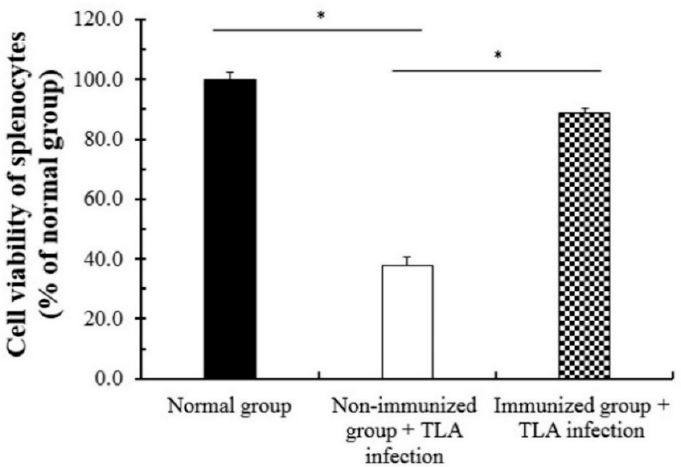
Figure 9. The viability of splenocytes after immunization. The splenocytes were collected from the spleen of mice at 4 weeks after boost immunization, and the cells were incubated with T. gondii lysate antigen (TLA) (1 µ g / mL) or without TLA for 72 h. The cell viability was measured by the MTT assay. The groups were divided into three groups as follows: the normal group, the non-immunized group infected with TLA (the non-immunized TLA infection group), and the TLA-infected group immunized with SAG1-VLPs (the immunized TLA infection